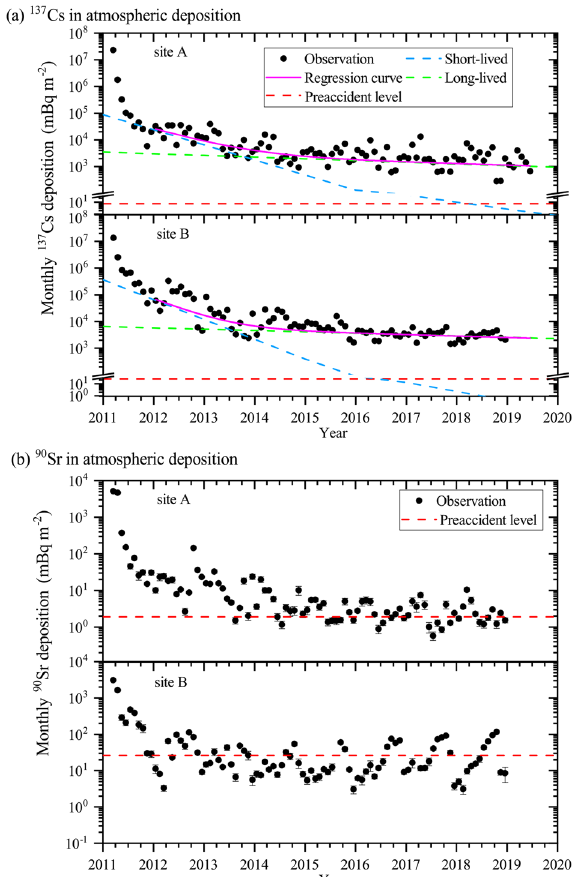
Figure 2. Activity of 90 Sr and 137 Cs in atmospheric depositions after the FDNPP accident from 2011 to 2018. ( a ) Cesium-137 in atmospheric depositions. ( b ) Strontium-90 in atmospheric depositions. The black points indicate the observational results. In panel (a), the pink lines indicate the regression curves. The green and blue curves indicate the exponential curves obtained via multiple exponential fitting. The red lines indicate the preaccident levels (the average monthly deposition between June 2009 and July